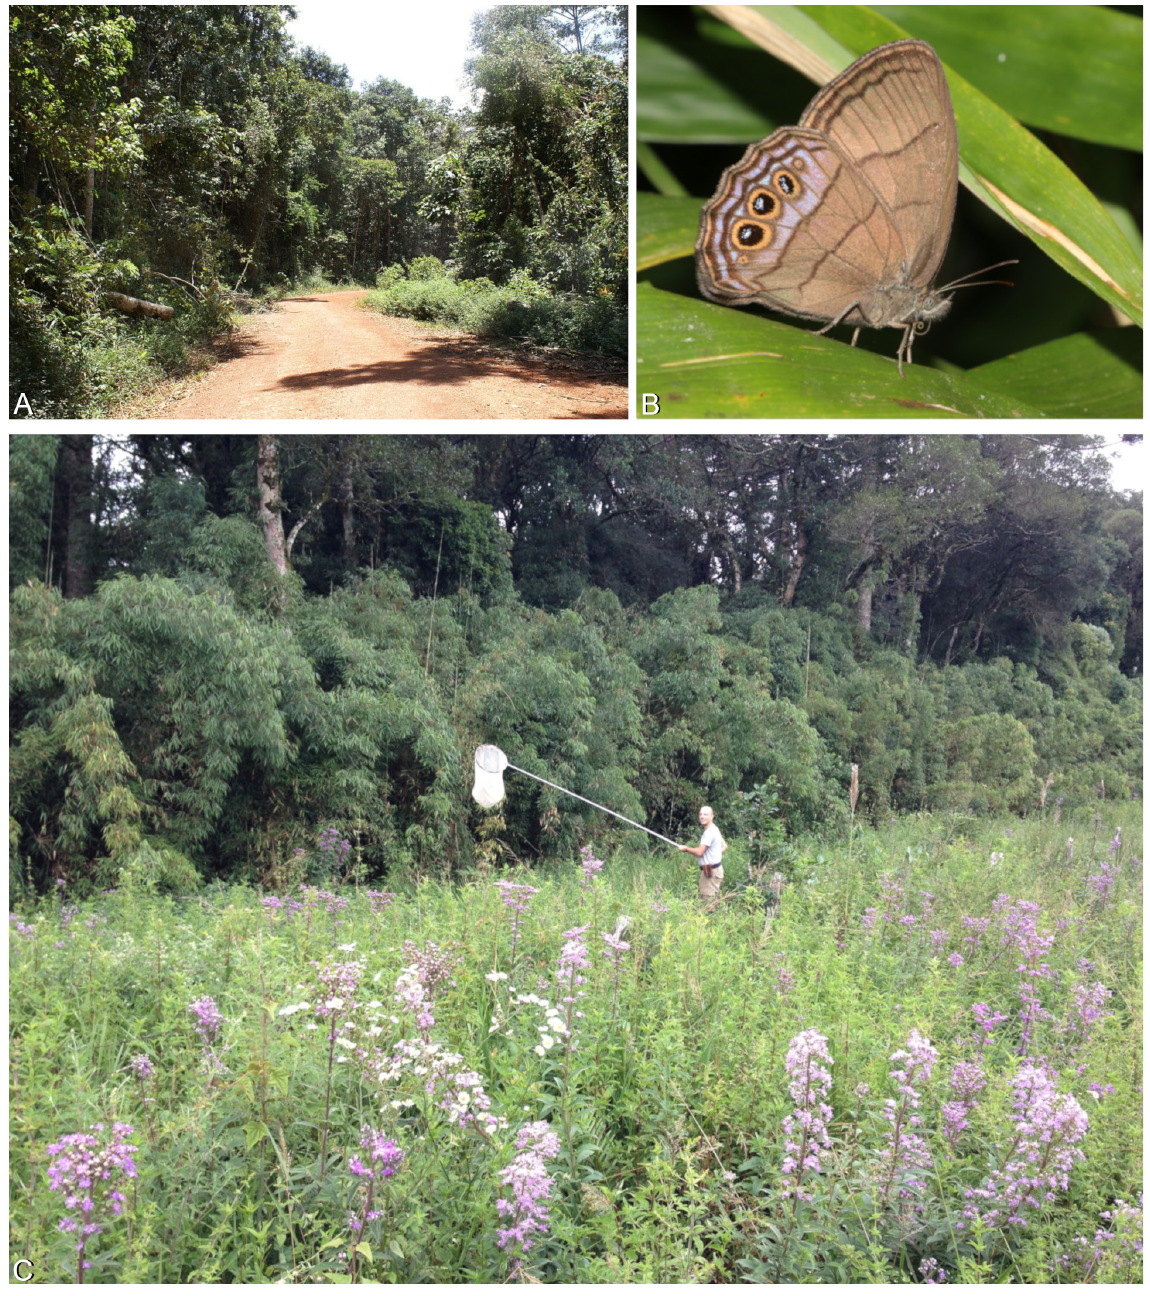
Fig. 16. Habitats of species of Zischkaia Forster, 1964. A . Habitat at the type locality of Z. josti Nakahara & Kleckner, sp. nov., Kavanayen, Venezuela (photo by Bernhard Jost). B . Adult in situ at Serra da Esperança, Guarapuava, Paraná, Brazil (photo by Andrew Warren). C . Habitat of Z. warreni Dias, Zacca & Dolibaina, sp. nov., Serra da Esperança, Guarapuava, Paraná, Brazil (photo by Andrew